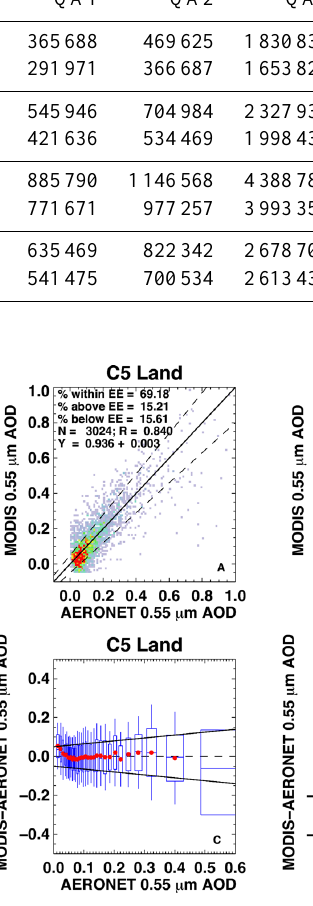
Fig. 11. Top row: frequency scatter plots for AOD at 0.55µm over dark-land compared to AERONET, plotted from 6 months of Aqua (January and July; 2003, 2008 and 2010), computed with C5 algorithm (a) and C6 algorithm (b) . One-one lines and EE en- velopes ± (0.05+15%) are plotted as solid and dashed lines. Col- location statistics are presented in each panel. Bottom row: the same information plotted as AOD error (MODIS-AERONET) ver- sus AERONET, broken into equal number bins of AERONET AOD for C5 c) and C6 (d) . One-one line (zero error) is dashed and EE envelopes are solid. For each box-whisker, its properties and what they represent include: width is 1- σ of the AOD bin, whereas height, whiskers, middle line and red dots are the 1- σ , 2- σ , mean and me- dian of the AOD error,